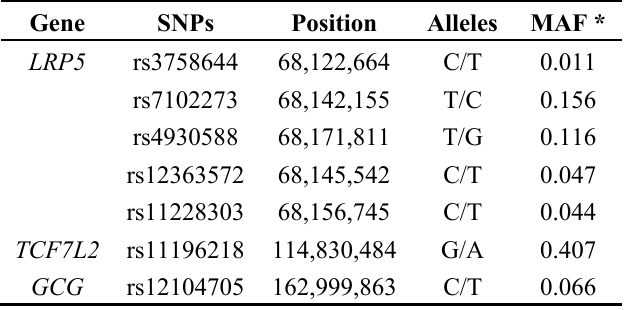
Table 12. The final selected SNPs involved in the present study. Gene SNPs Position